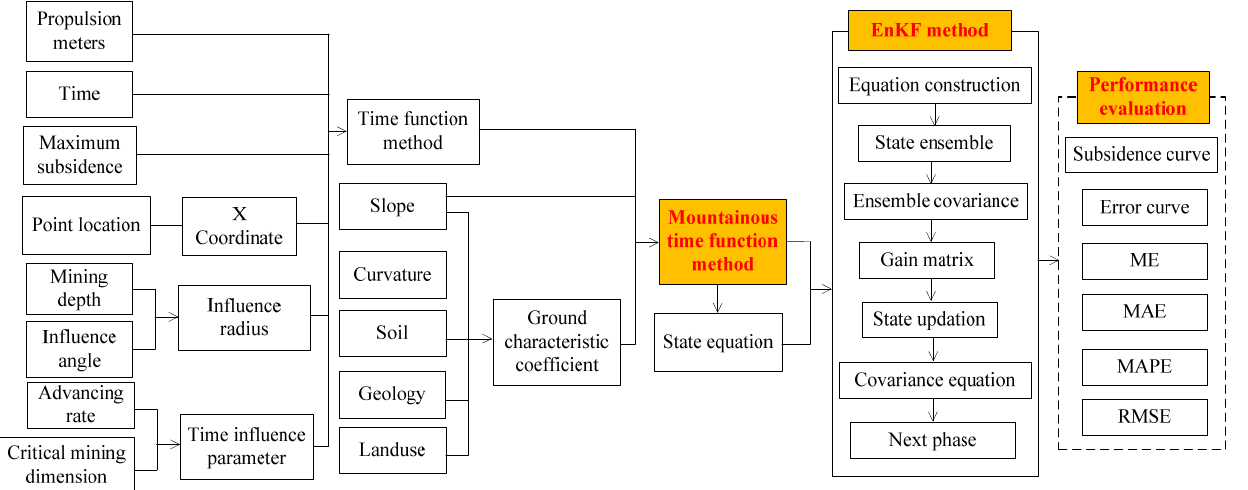
Figure 3. Work flow of this research.